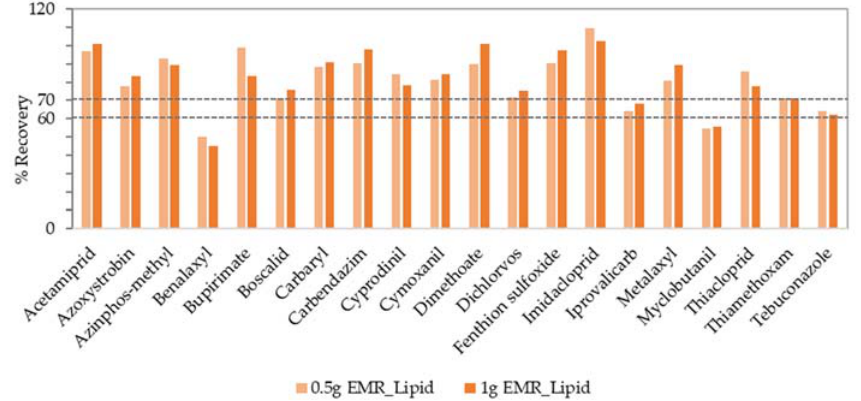
Figure 1. Recoveries (%) obtained for different amounts of sorbent used in cleanup step (0.5 g and 1 g EMR ‐ lipid) at 20 μ g kg − 1 spiking concentration level in milk.